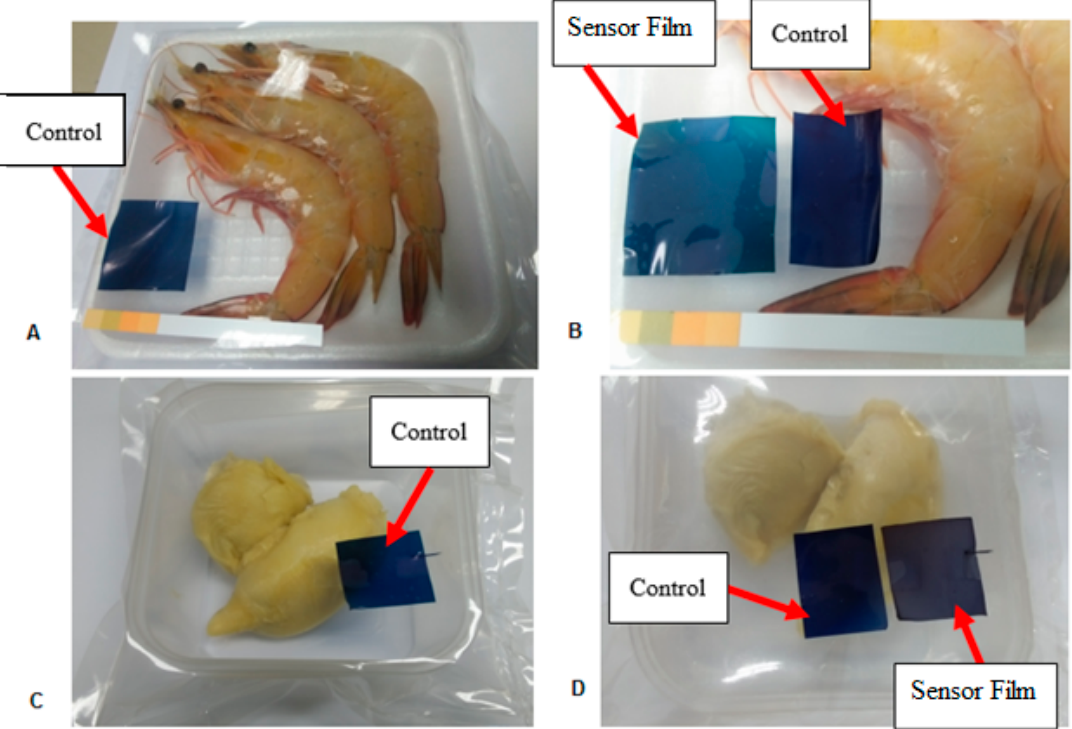
Figure 4. Application of sensing film for monitoring—( A ) shrimp freshness at 0 h (i) and after 2.5 h; ( B ) stored at ambient temperature; ( C ) durian freshness at: 0 days; ( D ) and after 4 days (ii) stored at ambient temperature.